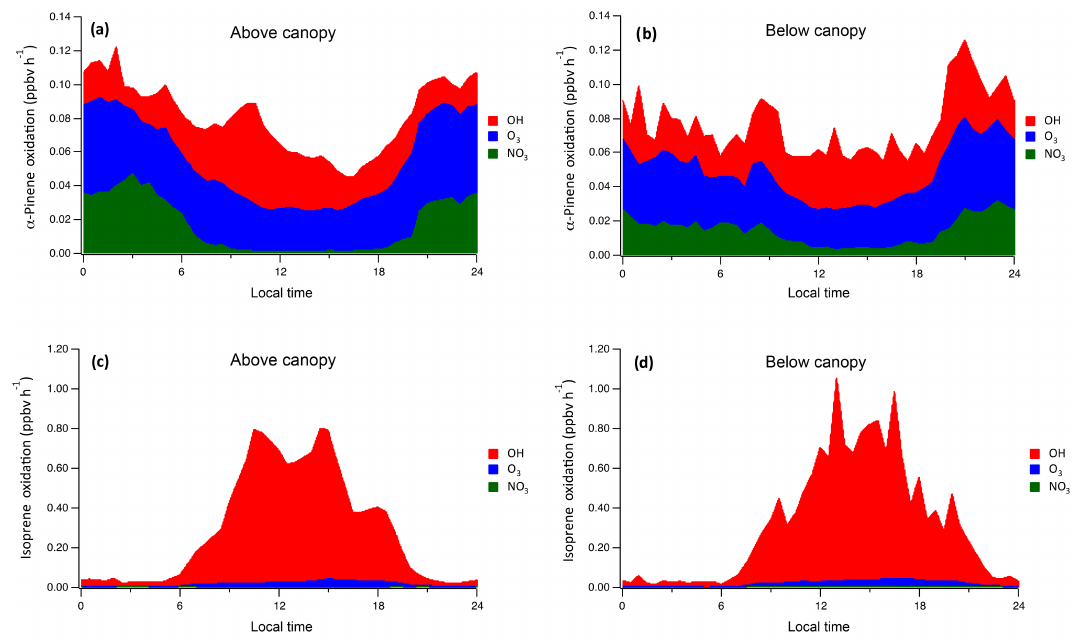
Figure 3. Modeled diurnal oxidation rates of (a) α -pinene above canopy, (b) α -pinene below canopy, (c) isoprene above canopy, and (d) iso- prene below canopy by OH, O 3 , and NO 3 .